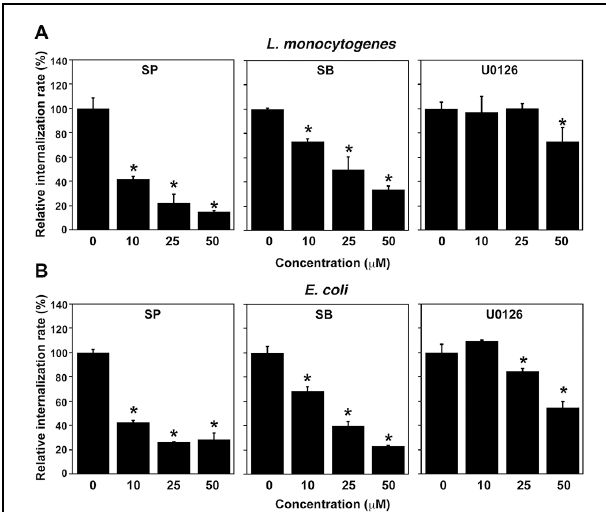
FIGURE 3 | Treatment with MAPK inhibitors inhibits L. monocytogenes infection in TG cells. (A) Effect of MAPK inhibitor treatment on L. monocytogenes infection. TG cells were treated with SP600125 (SP; JNK inhibitor), SB203580 (SB; p38 inhibitor), or U0126 (ERK1/2 inhibitor) at the indicated concentration for 1 h and then infected with L. monocytogenes for 30 min at an MOI of 10. (B) Effect of MAPK inhibitor treatment on uptake of Escherichia coli . TG cells were treated with MAPK inhibitors as described above and then infected with E. coli for 30 min at an MOI of 10. (A,B) All values represent the means and SD of triplicate samples from three identical experiments. ∗ P < 0.05 compared with bacterial internalization in TG cells without treatment by post hoc Tukey–Kramer